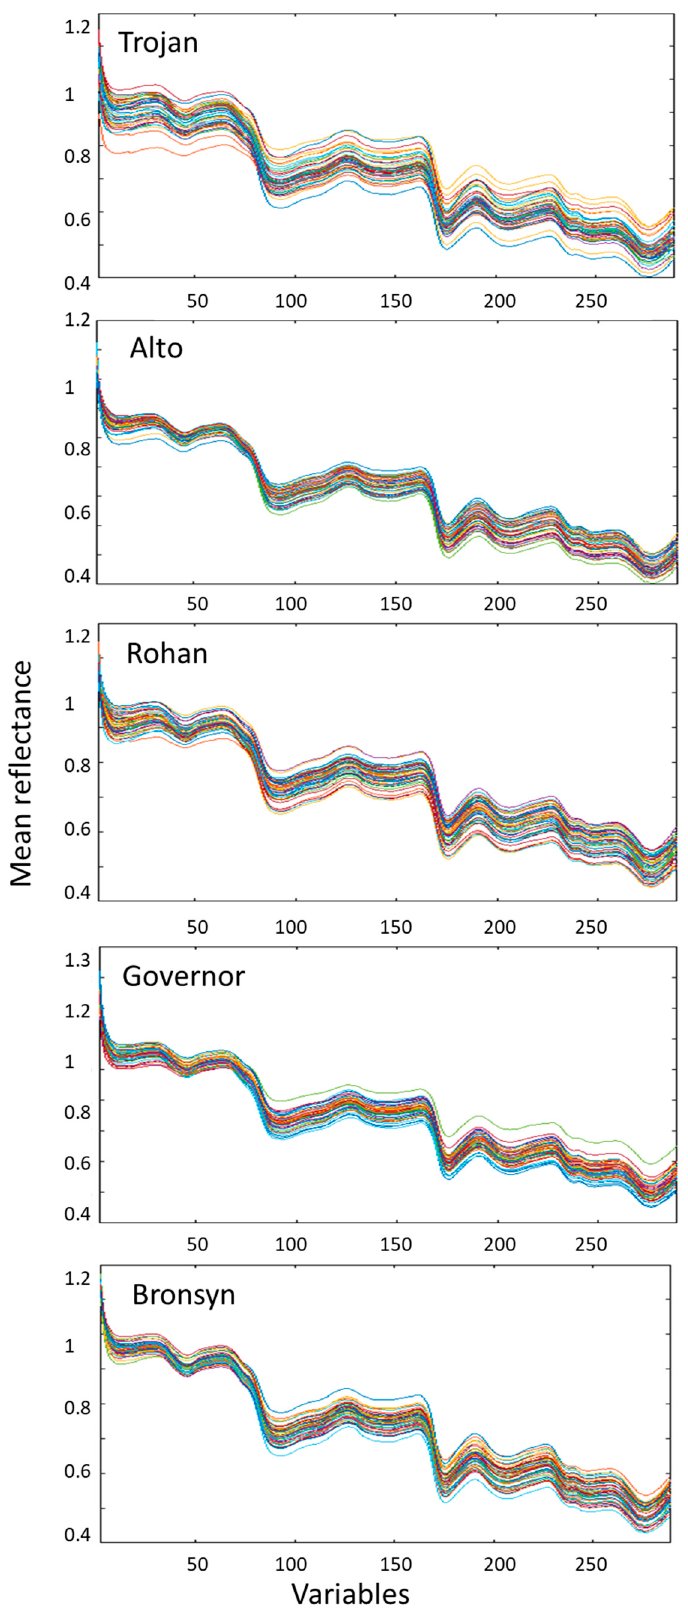
Figure 4. Raw NIR spectra of Trojan, Alto, Rohan, Governor and Bronsyn. The variables represent 288 wavelengths acquired in the spectral range (1000–2500 nm).